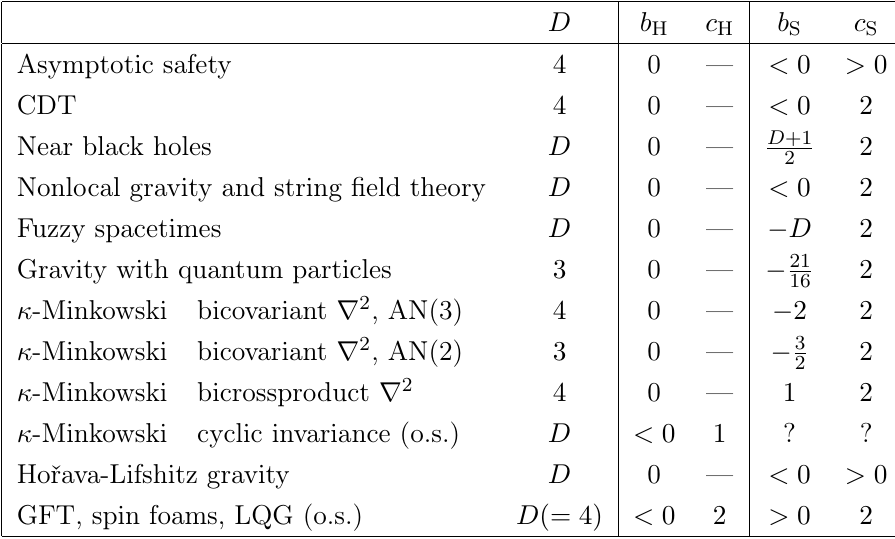
Table 3 . Parameters of the IR Hausdorff and spectral dimension of spacetime (3.2) (subscript H and S, respectively) in quantum gravities. “Only space” (o.s.) cases means that ‘ in eq. (3.2) is a spatial scale (time dimension does not flow). Question marks indicate cases not studies in the